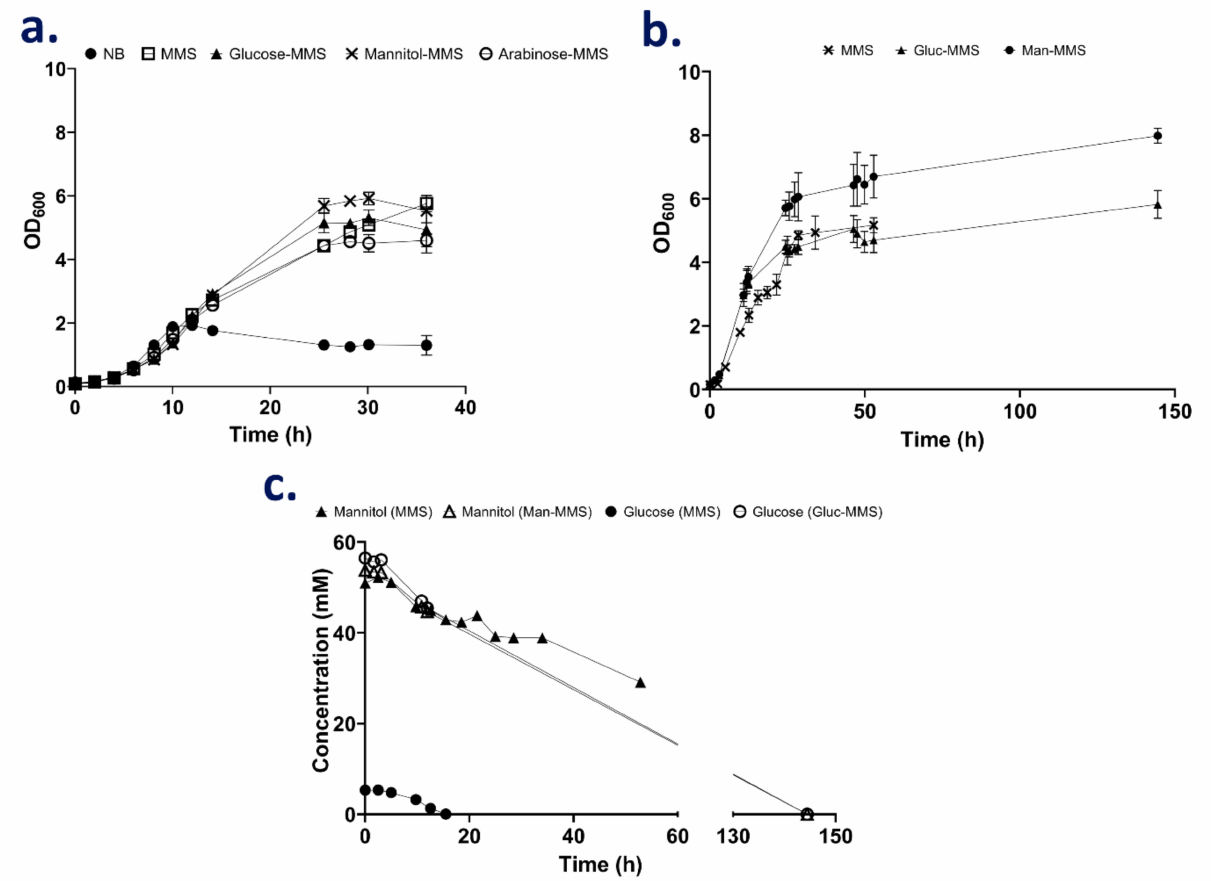
Figure 3. Batch cultivation of SOS3 in semi-defined media. ( a ) Growth curves in Shake flasks. ( b ) Growth curves in instrumented bioreactors. ( c ) Substrate consumption in instrumented bioreactors. pH and dissolved oxygen were controlled at 7.0 and 50%, respectively. Data correspond to the average of two